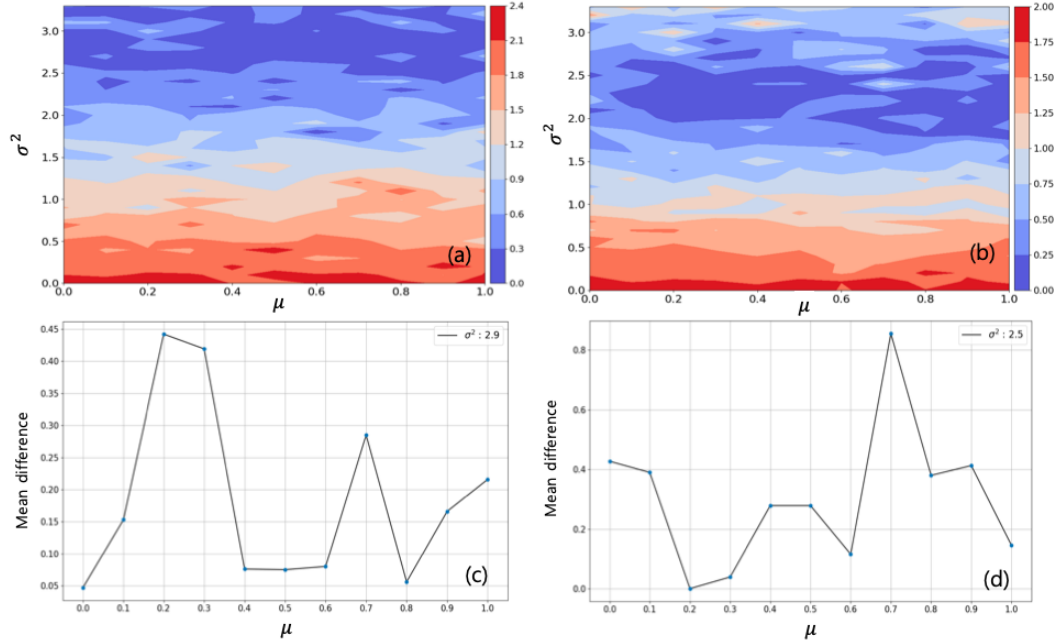
Figure 8. Mean difference fields of tsunami in ( a ) 1983 and ( b ) 1993, and the variation of mean difference along mean at stationary standard deviation over tsunami in ( c ) 1983 and ( d ) 1993.